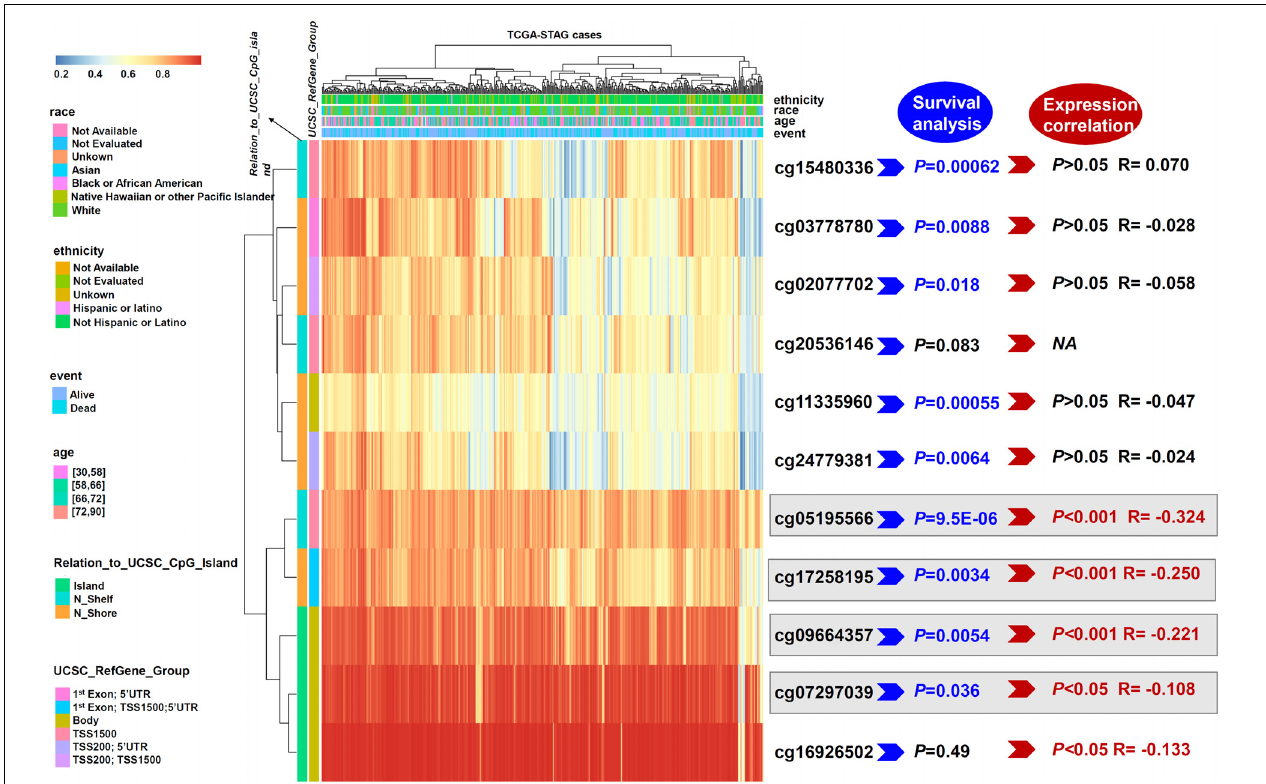
FIGURE 4 | Waterfall plot and analysis of potential methylation probes targeting the ISLR gene. A waterfall plot of the methylation level of the ISLR gene is provided. The correlations between ISLR methylation or expression level and survival rate were also analyzed. NA, not